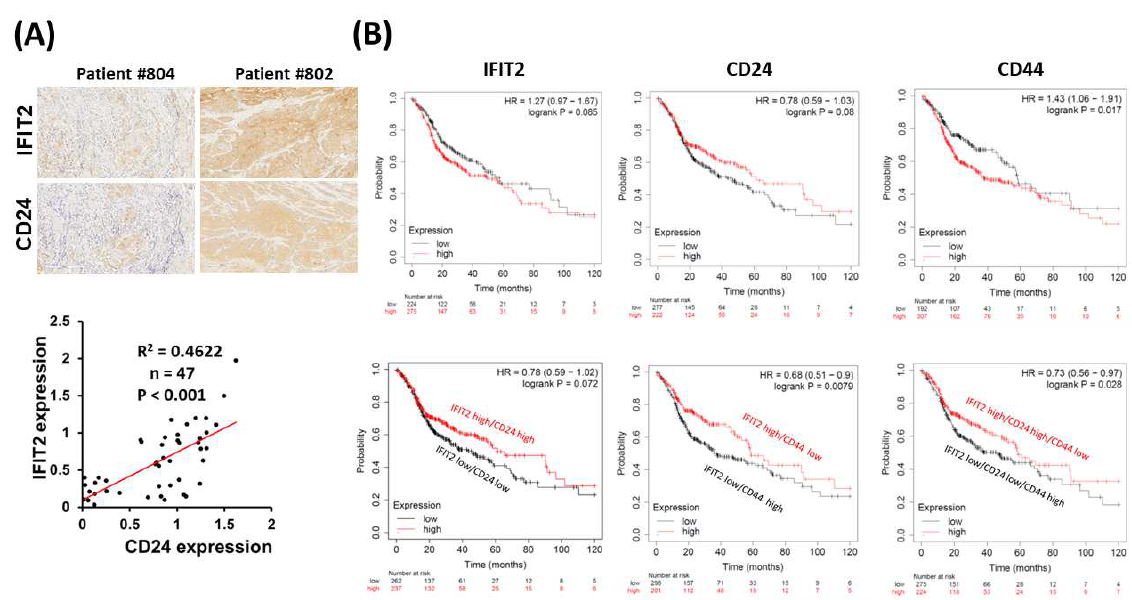
Figure 4. Clinical value of IFIT2 and CSC markers. ( A ) Representative images of low and high immunostaining for IFIT2 and CD24 proteins in OSCC patients (patient IDs: #804 and #802). Correlation between IFIT2 and CD24 expression in OSCC. The p value was determined by the Pearson correlation coefficient test; ( B ) Kaplan–Meier plotter analysis of overall survival in 499 HNC patients grouped according to IFIT2, CD44, and CD24 expression. The data were obtained from TCGA.